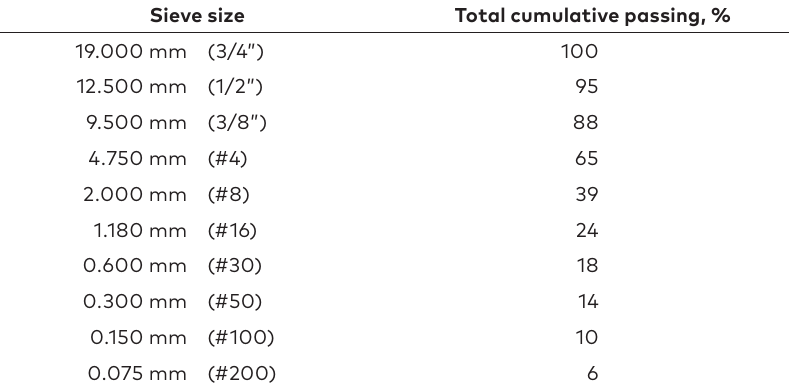
Table 2. Combined aggregate gradation